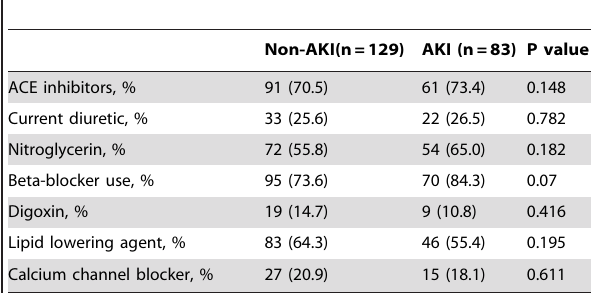
Table 2. Preoperative Medication Use in Patients Undergoing Cardiac Surgery.